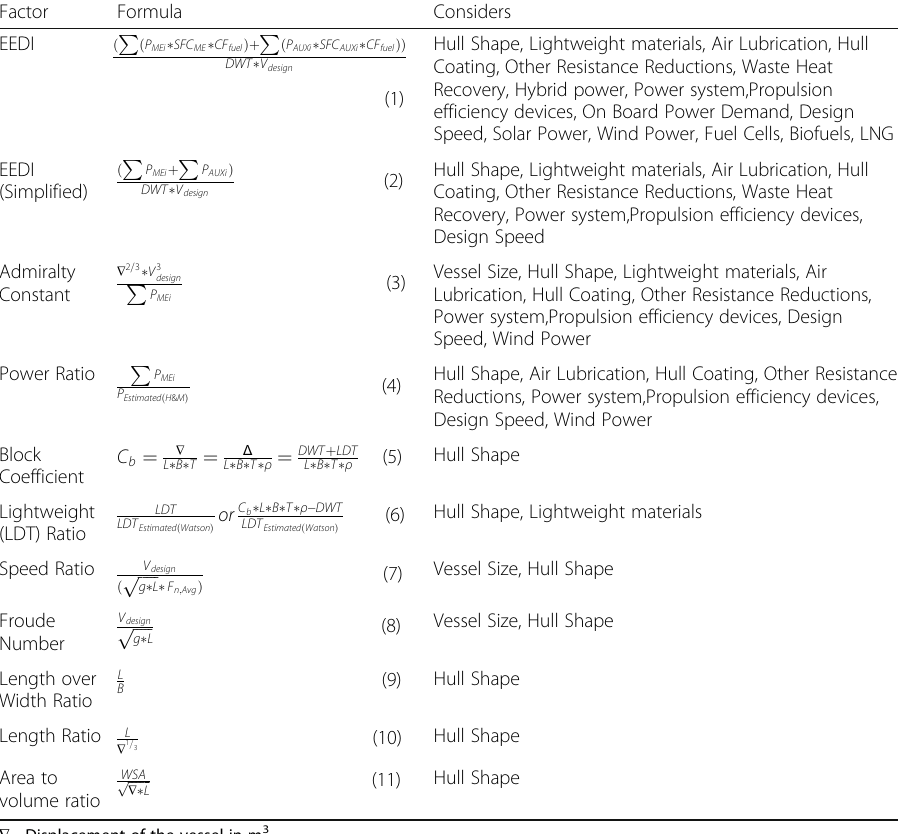
Table 1 Overview of indicators their formula and which improvements are considered Factor Formula